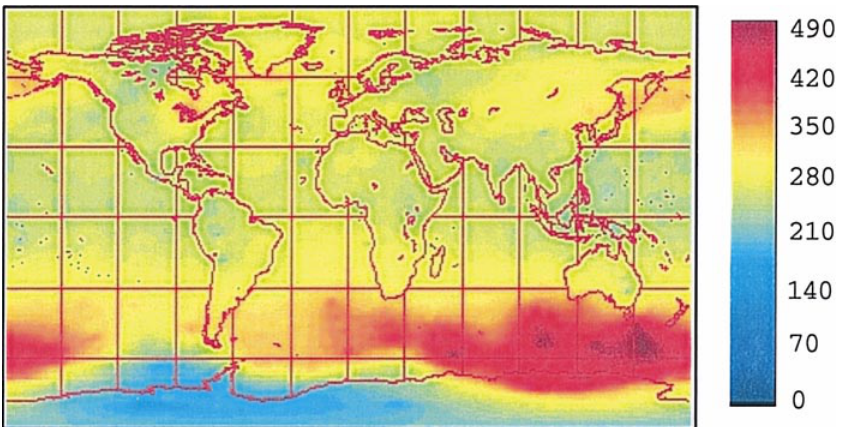
Fig. 7. Total SBUV ozone field in Dobson Units obtained from ordinary kriging with the exponential model ( C 0 (cid:136) 0, C 1 (cid:136) 3300 and R (cid:136) 28), October 5, 1988. Interval is 10